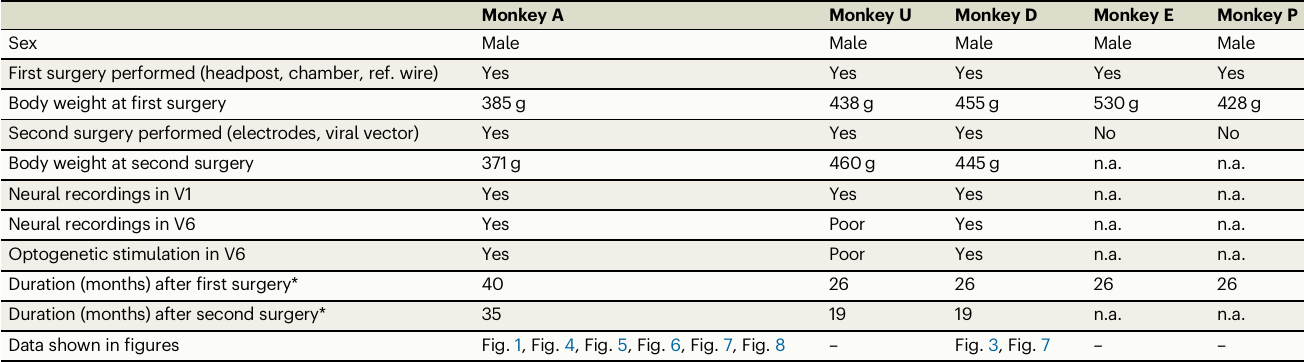
Table 1 | List of all animals, procedures and outcomes